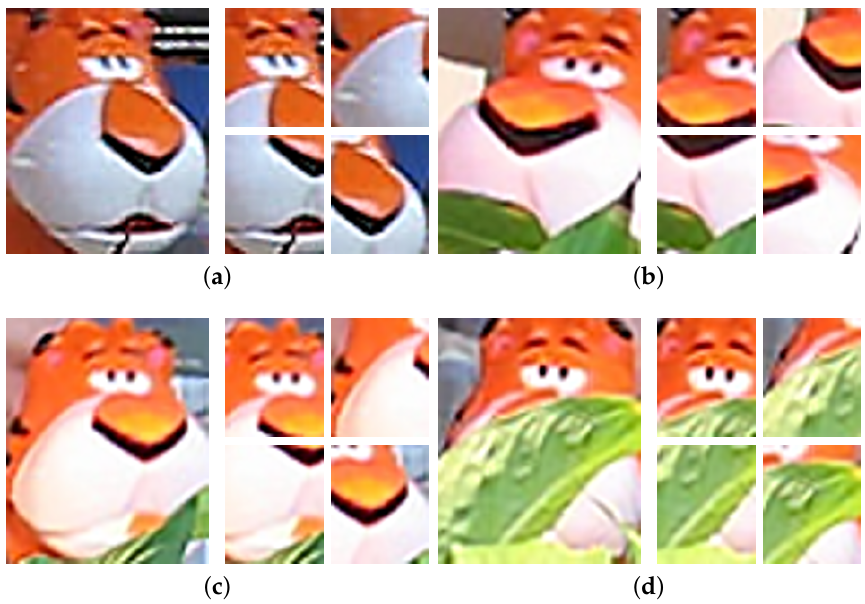
Figure 3. The whole block and its partial blocks from Tiger2 in OTB-100. ( a ) 1st frame without occlusion; ( b ) 95th frame with slight occlusion; ( c ) 115th frame with slight occlusion; ( d ) 256th frame with large